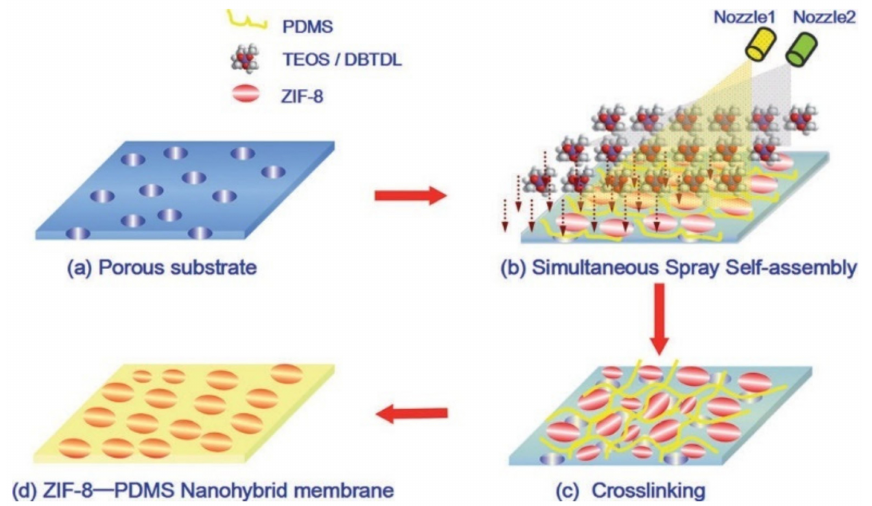
Figure 9. Simultaneous self-spray assembly method [48]—(Reprinted from Angewandte Chemie (International ed. in En- glish), Fan, H.; Shi, Q.; Yan, H.; Ji, S.; Dong, J.; Zhang, G. Simultaneous Spray Self-Assembly of Highly Loaded ZIF-8-PDMS Nanohybrid Membranes Exhibiting Exceptionally High Biobutanol-Permselective Pervaporation., pp. 5578–5582, Copyright (2021), with permission from